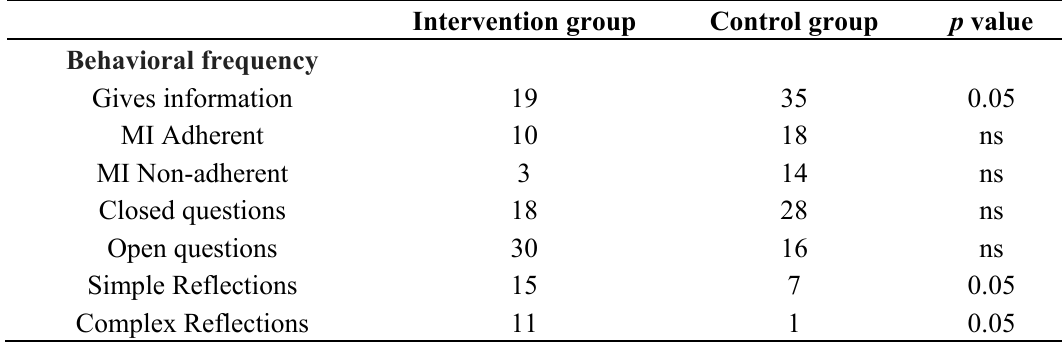
Table 3. Overall data regarding the behavioral frequency from the intervention group and the control group, according to MITI 3.1, by using Mann-Whitney